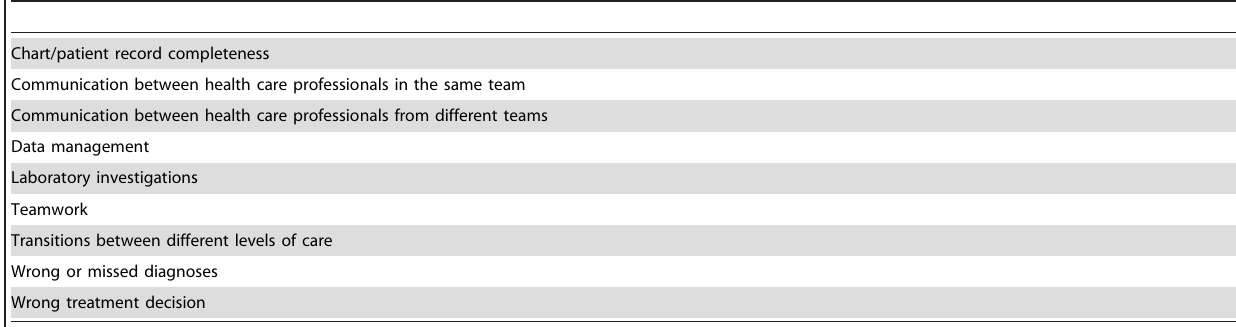
Table 3. Causes of patient safety incidents and their associated harm that were considered in need of further study by over 80% of participants after round 3 across all income settings.